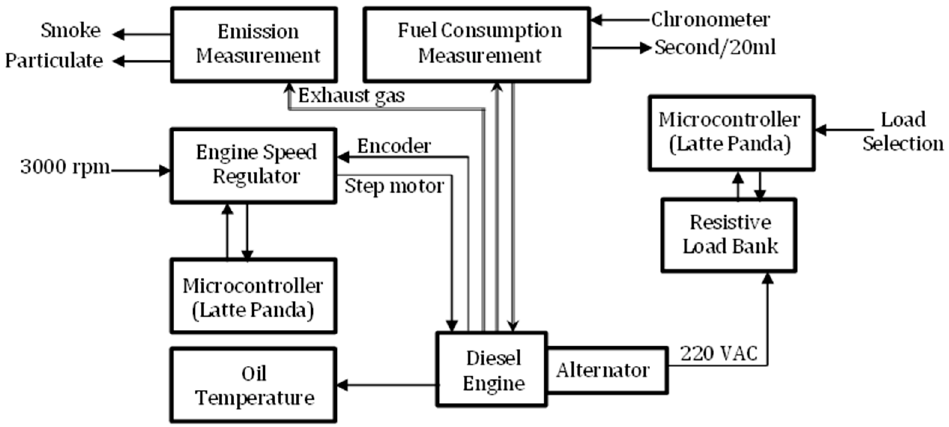
Figure 2. Experimental setup.